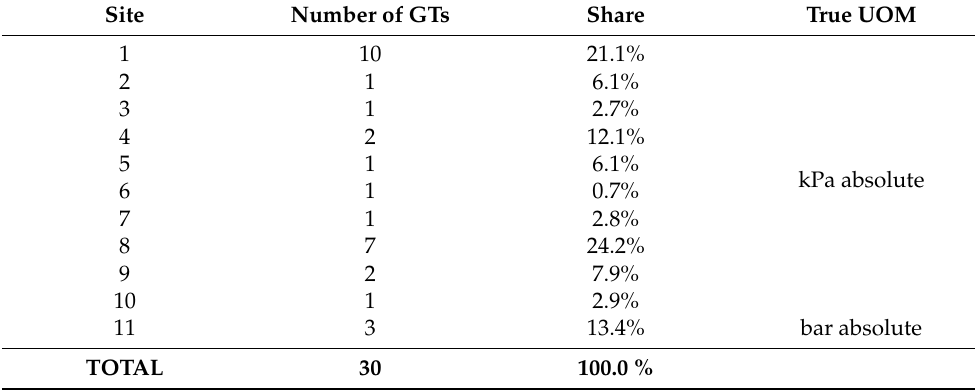
Table 1. Dataset